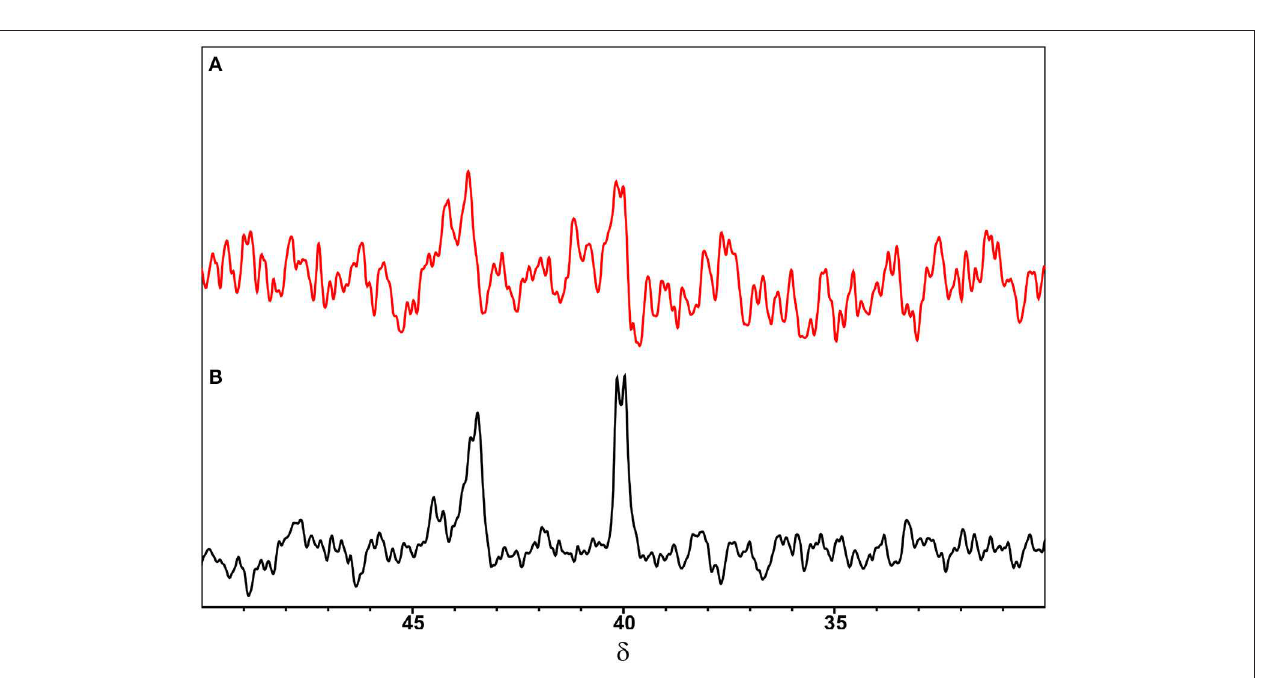
final CBLAU/CT-DNA adduct formation (1.40 s) in